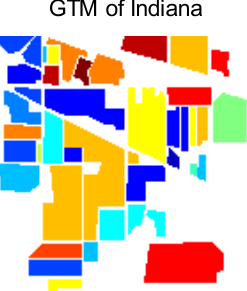
Figure 1. Ground truth map of Indian pines dataset